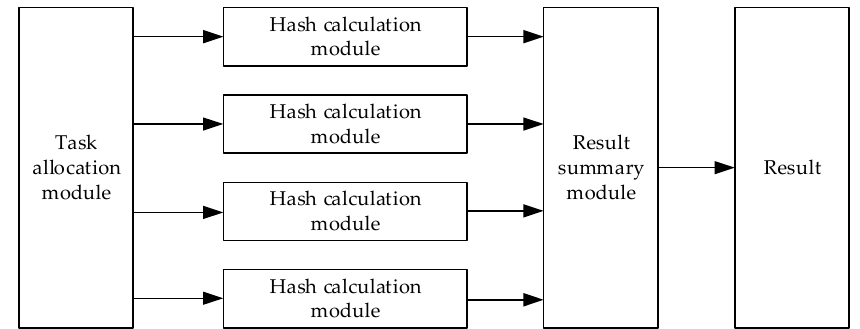
Figure 9. Distributed parallel processing method.